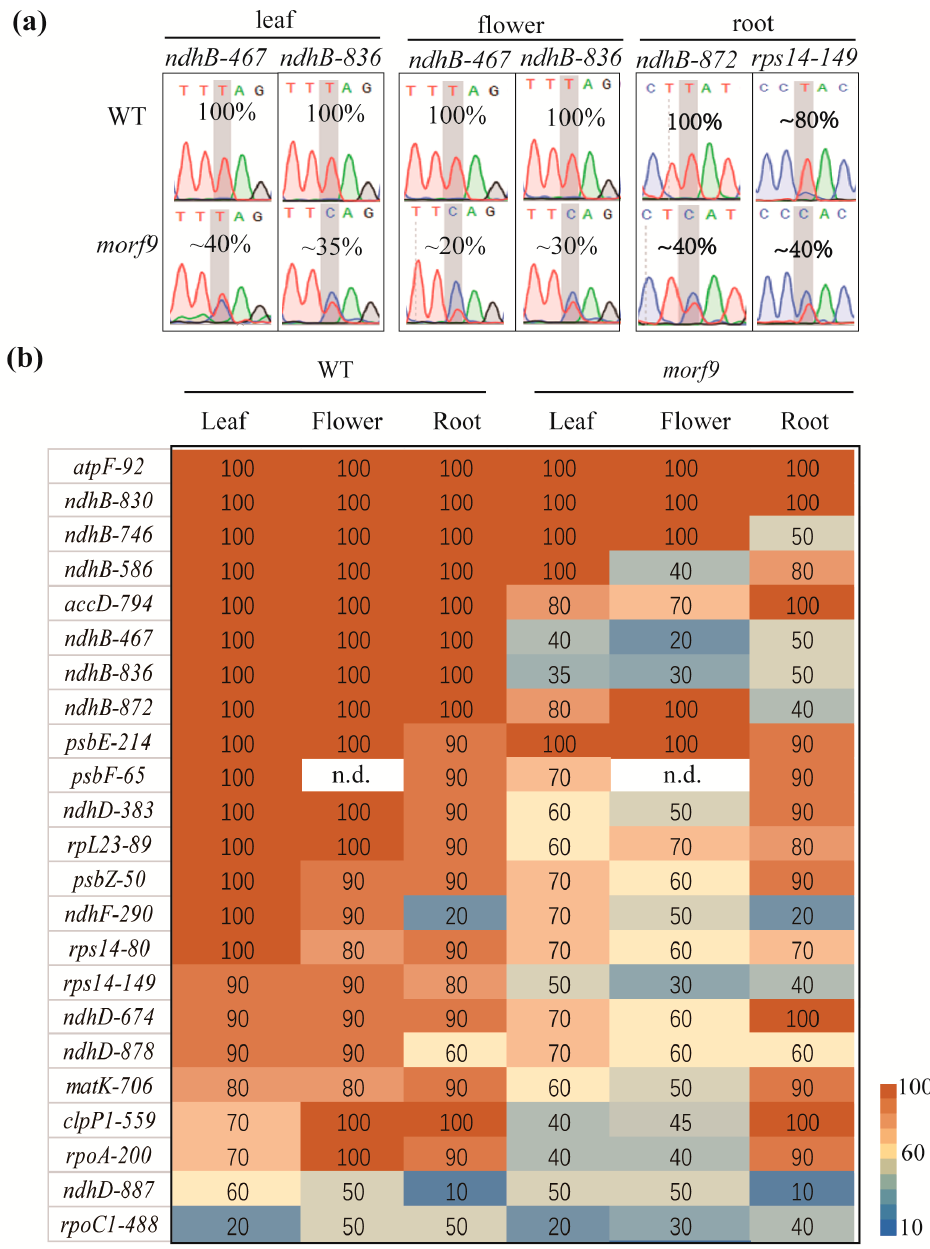
Figure 5. Percent editing of 24 plastid RNA sites in various organs of WT and morf9 seedlings. ( a ) Nucleotide sequence profiles of the RNA editing sites in leaf, flower, and root most significantly affected by morf9 mutation; ( b ) A heatmap of RNA editing efficiencies for multiple editing sites in various organs of WT and morf9 plants. Leaf and root samples were collected in seedlings after 21 days of growth in sugar-free medium. For flower sampling, 56-day-old plants were used.